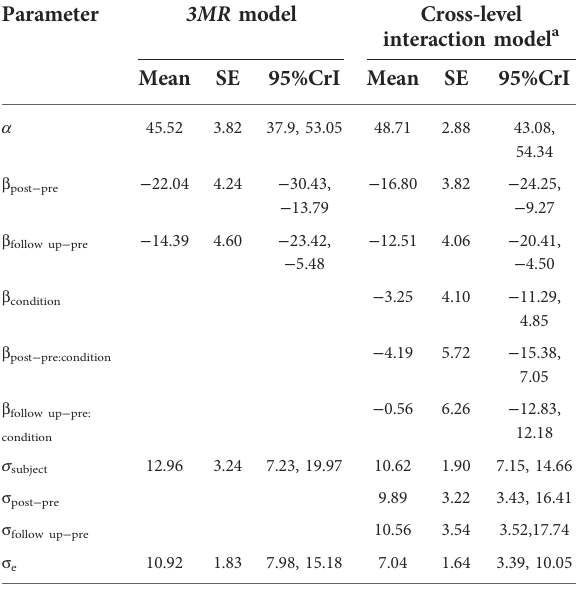
(-15.02, − 5.54)] between the pre and post measurement and TABLE 4 Posterior mean, standard error, 95% credible interval for each parameter in model predicting PCL-5 scores. − 9.03 from pre to follow-up [95%CrI (-14.24, − 4.21)], again Parameter 3MR model Cross-level excluding zero from both 95% credibility intervals. interaction model